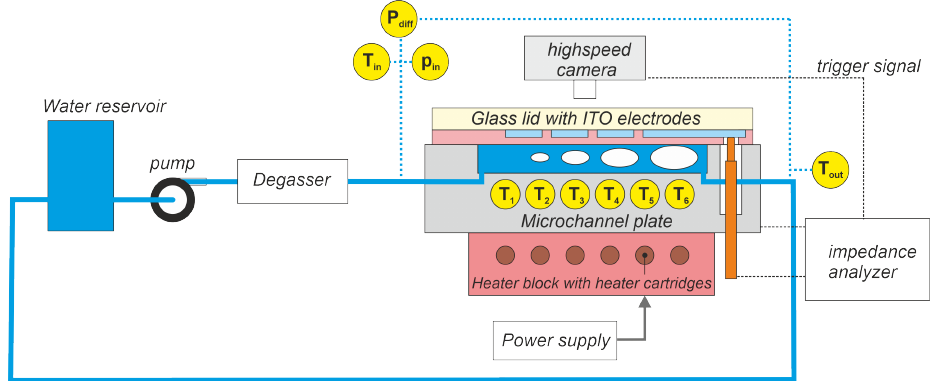
Figure 1. Schematic of experimental